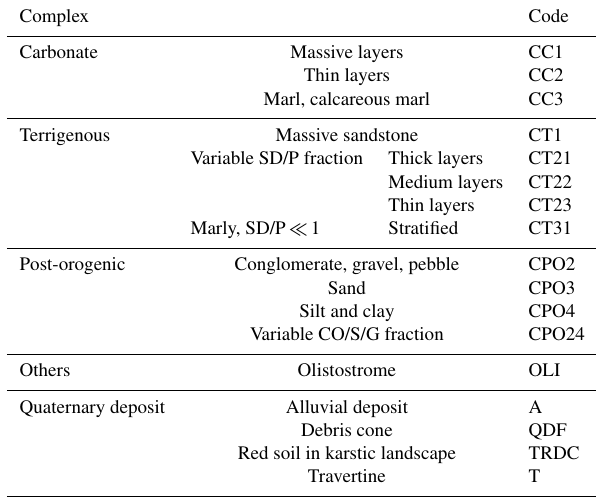
Table 1. Lithological codes used in Fig. 5. SD is sandstone, P is pelitic rock, CO is conglomerate, S is sand, G is clay (Regione Um- bria,